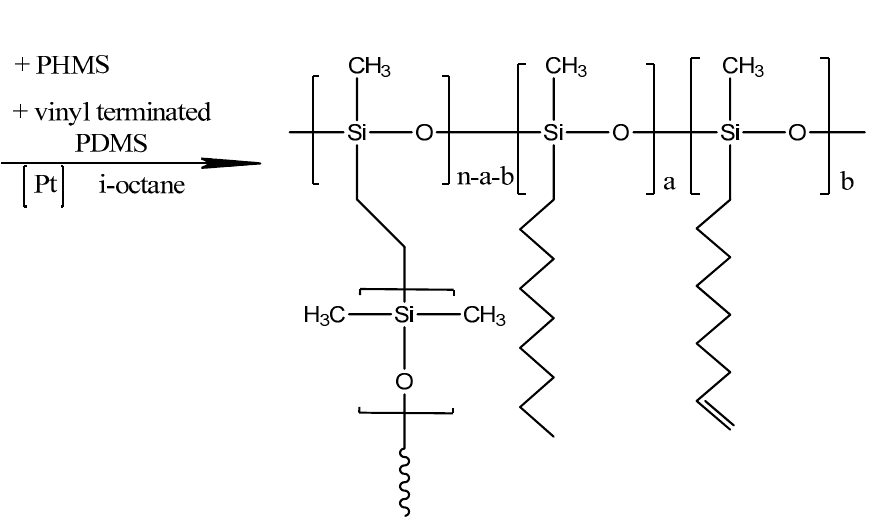
Figure 1. Scheme of POMS synthesis.